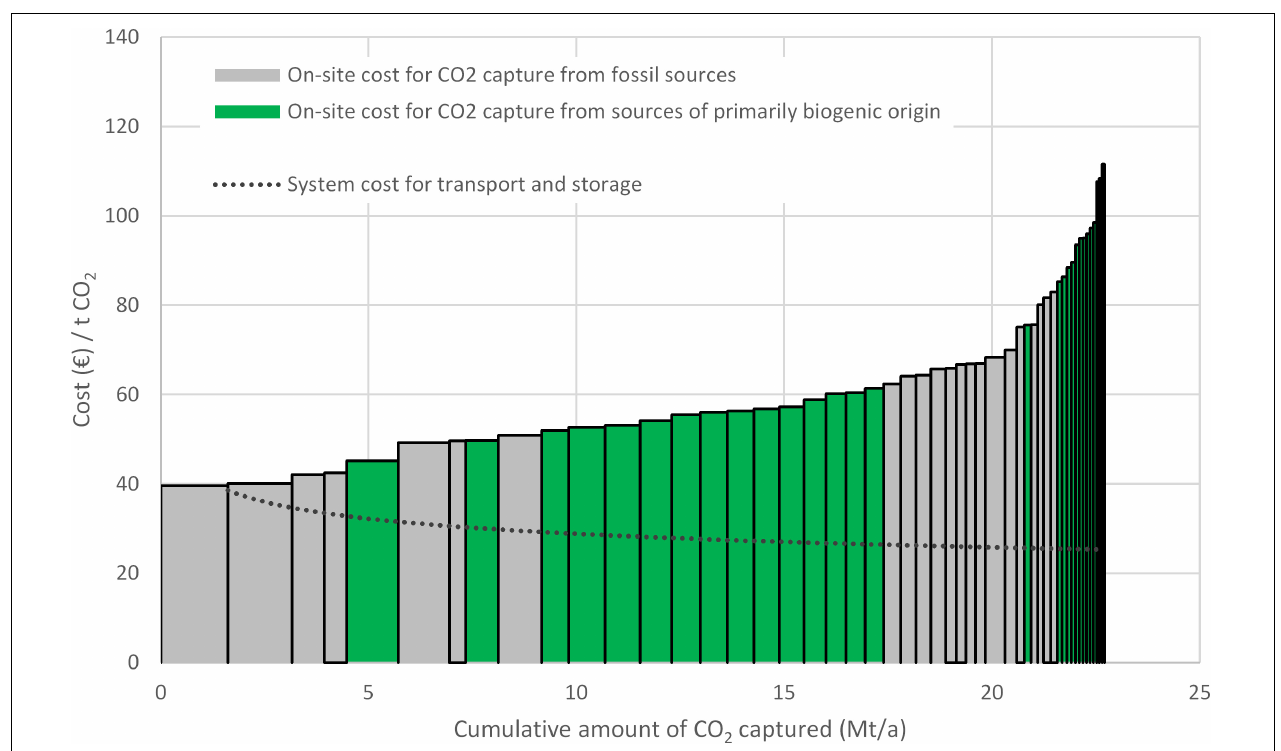
FIGURE 1 | Marginal abatement cost curve for carbon capture and corresponding costs for a transport and storage system (including capital and operating costs) from Swedish emission sources > 500 kt CO 2 /a. It should be noted that the cost for ship transport and storage at a specific point of the curve is not directly addable to the capture cost for any specific emission source – as the transport and storage cost for one plant will depend on the volumes of CO 2 handled by the entire